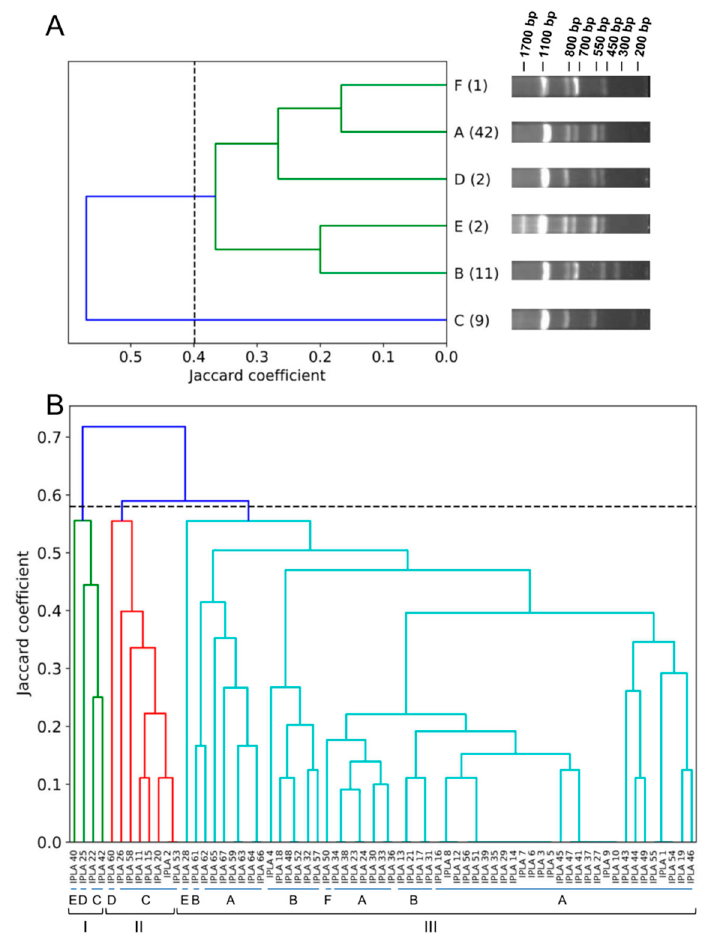
Figure 2. Dendrograms representing clustering analysis of clinical MRSA strains by UPGMA using the Jaccard similarity coefficient. ( A ) Clustering based on RAPD-PCR. The blue line represents strains that were not included in any cluster (isolates with RAPD (Random amplification of polymorphic DNA) profile (C). Separate clusters are shown in different colors. The cut-off value for clustering was 0.399. A, B, C, D, E and F represent the six distinct RAPD profiles. The numbers in brackets indicate how many strains have each profile. ( B ) Clustering based on RAPD profile plus the possession or not of certain virulence and resistance genes. Separate clusters appear in different colors. The cut-off value for clustering was 0.58.